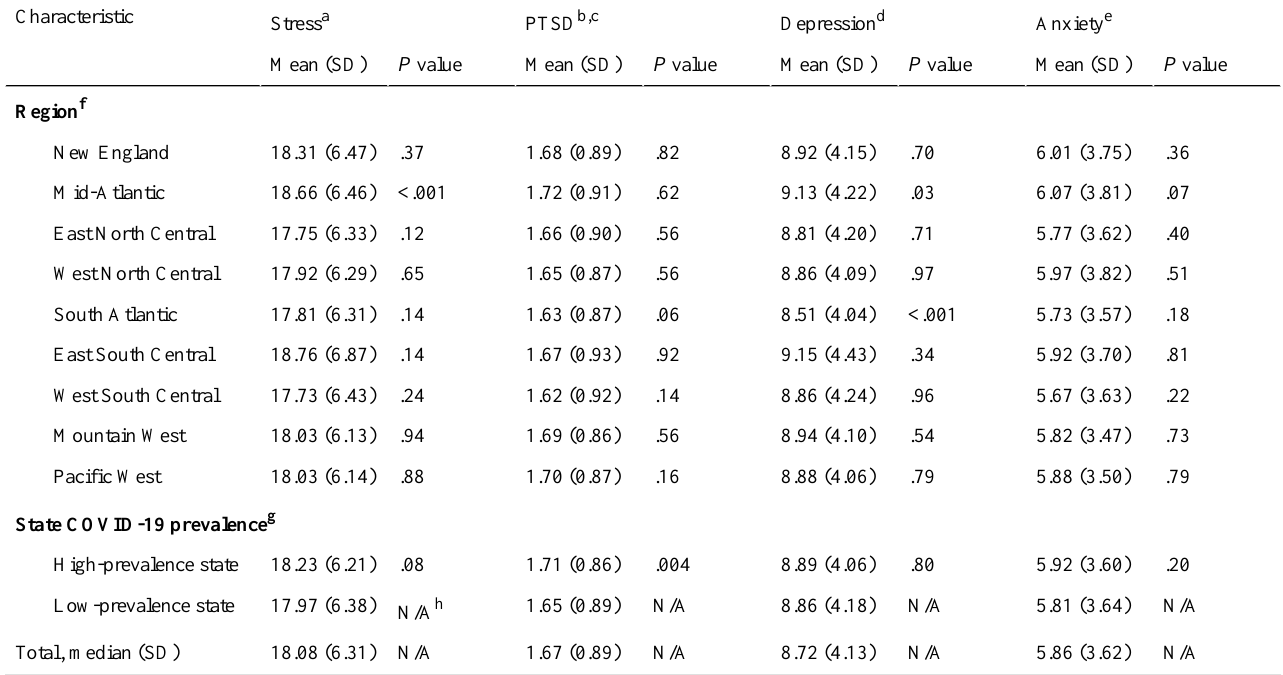
Table 3. Differences in mental health by region and state-level COVID-19